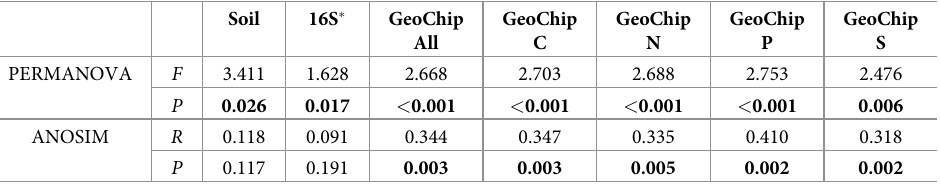
Table 2. PERMANOVA and analysis of similarity (ANOSIM) results between 4